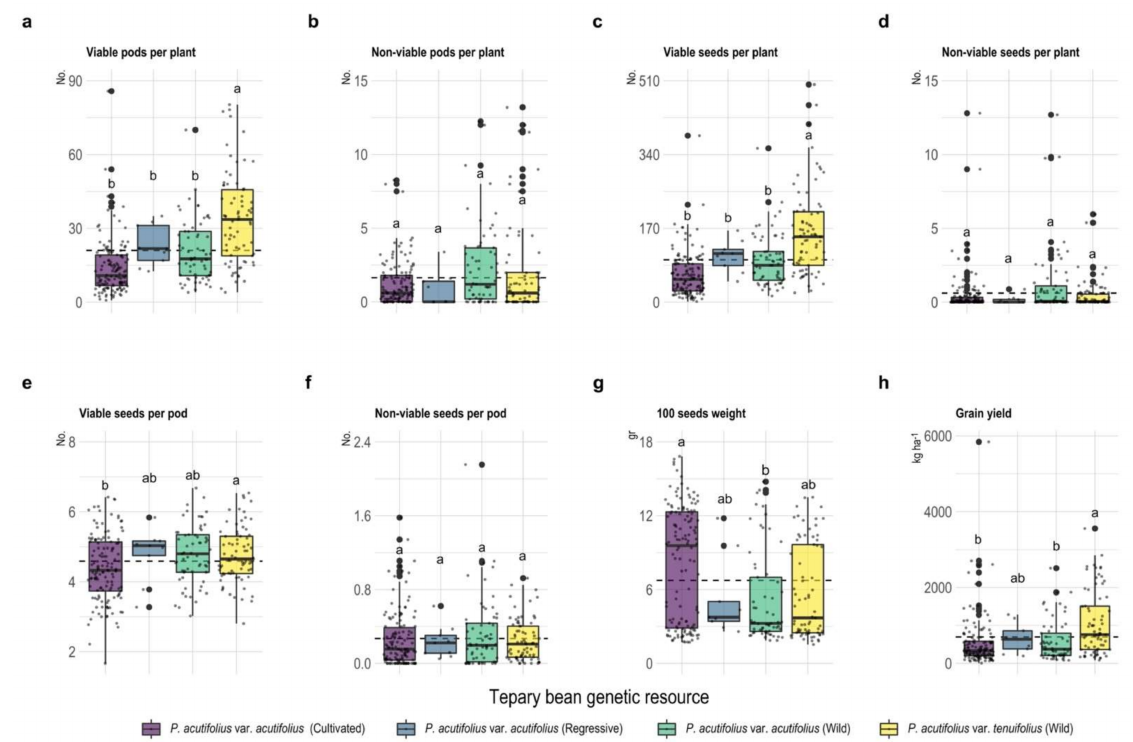
Figure 2. Box plots of the scatter plot for agronomic grain characteristics in terms of viable and non-viable seeds per plant ( a – d ), viable and non-viable seeds per pod ( e , f ), 100 seeds weight ( g )